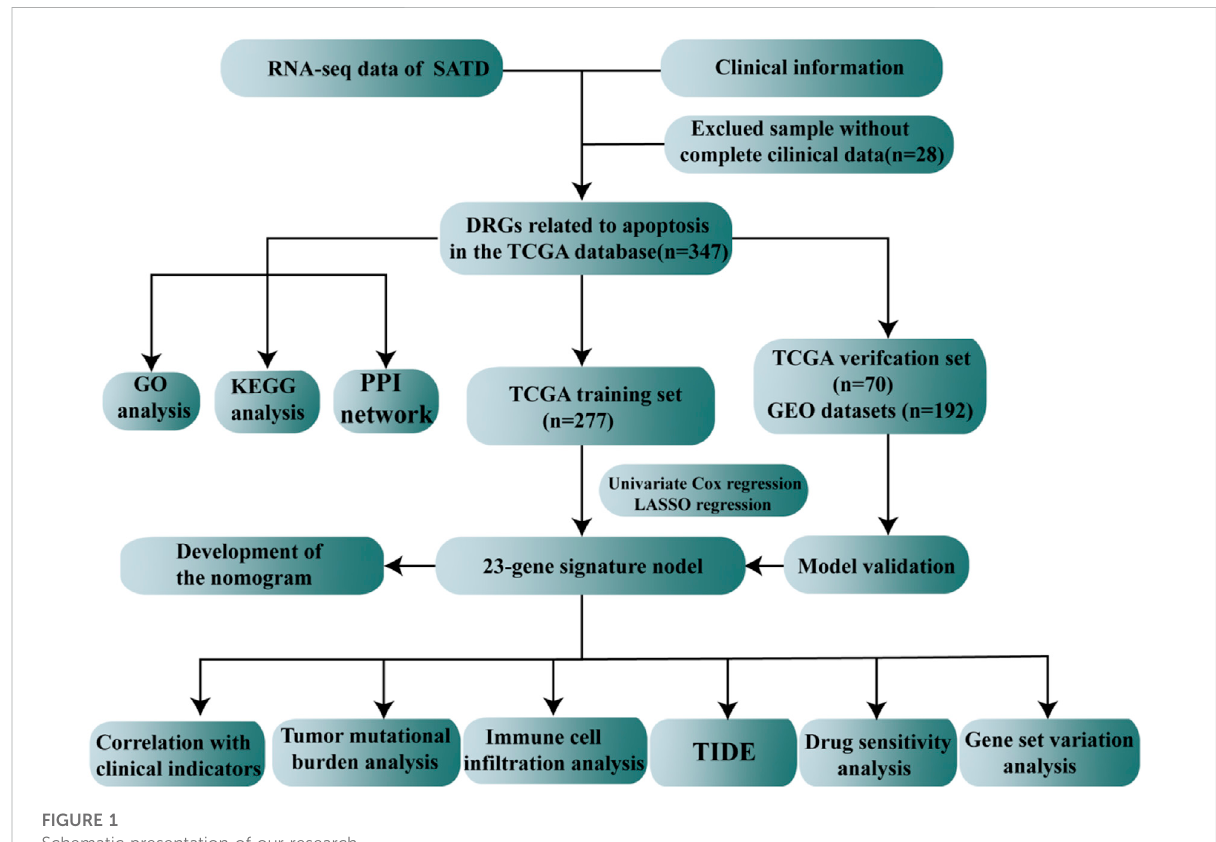
FIGURE 1 Schematic presentation of our